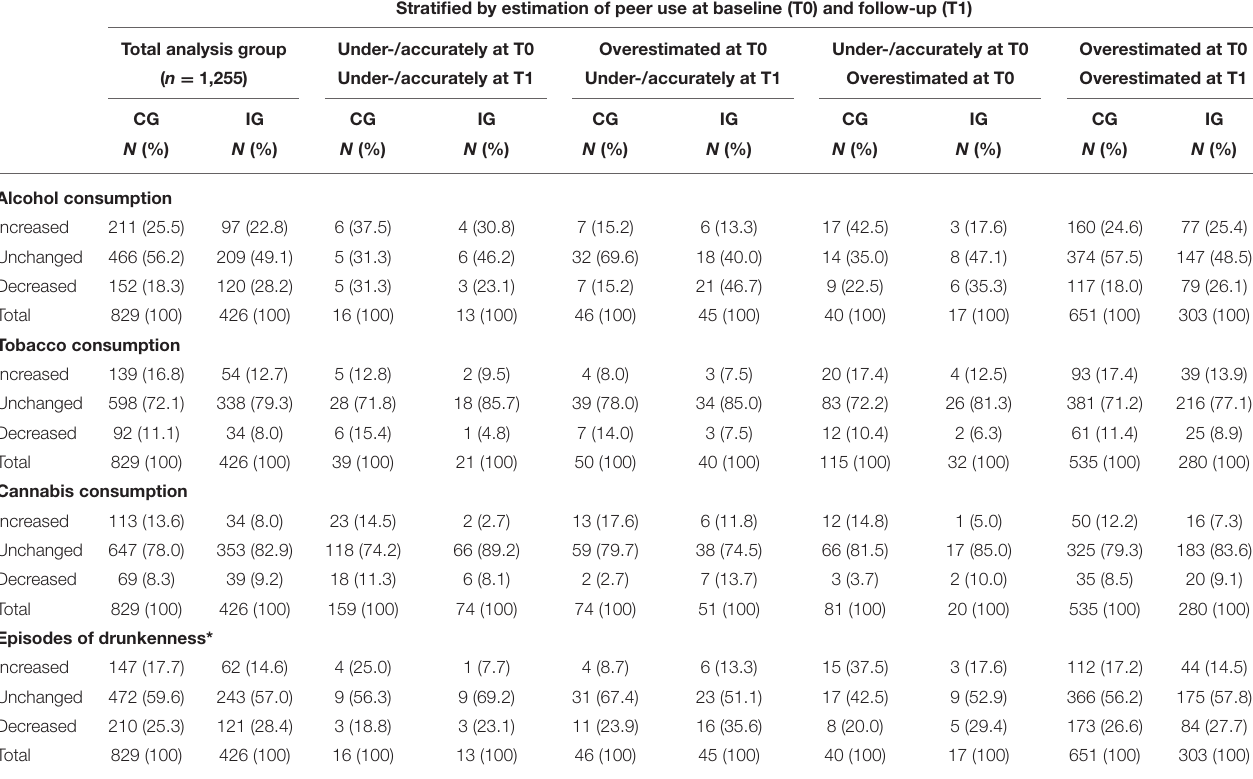
TABLE 3 | Change of alcohol, tobacco, cannabis consumption and change in episodes of drunkenness (increased, unchanged, decreased) 5 months post-intervention (stratified by estimation of peer use at T0/T1). Stratified by estimation of peer use at baseline (T0) and follow-up